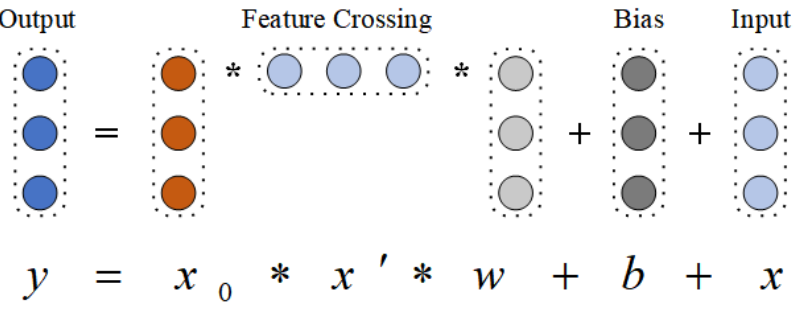
Figure 8. The visualization of a cross layer [22].